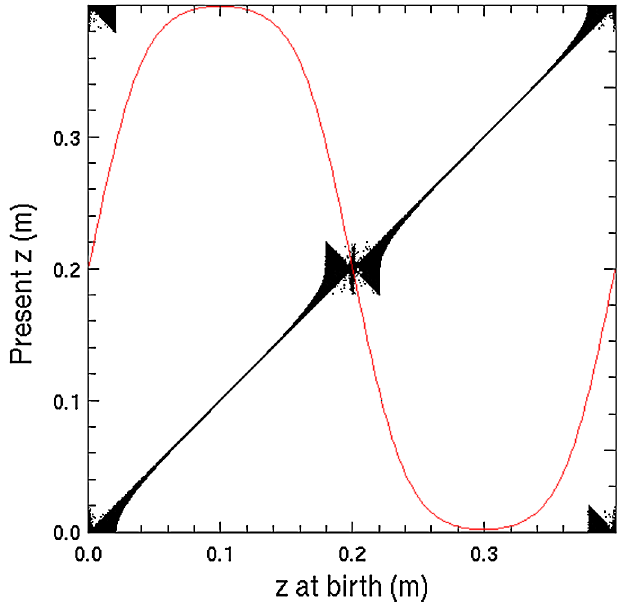
FIG. 8. Movement in z of macroelectrons in the simulation. Each dot represents one macroparticle. Snapshot at t ¼ 701 ns . The field nulls are at z ¼ 0 : 0 , 0.2, 0.4 m. The sinusoidal-like line shows B y vs z . Note that electrons in the upper left and lower right of the diagram are a result of the periodic boundary conditions in z and should be consid- ered as a continuation of the density at the opposite z edge of the plot.